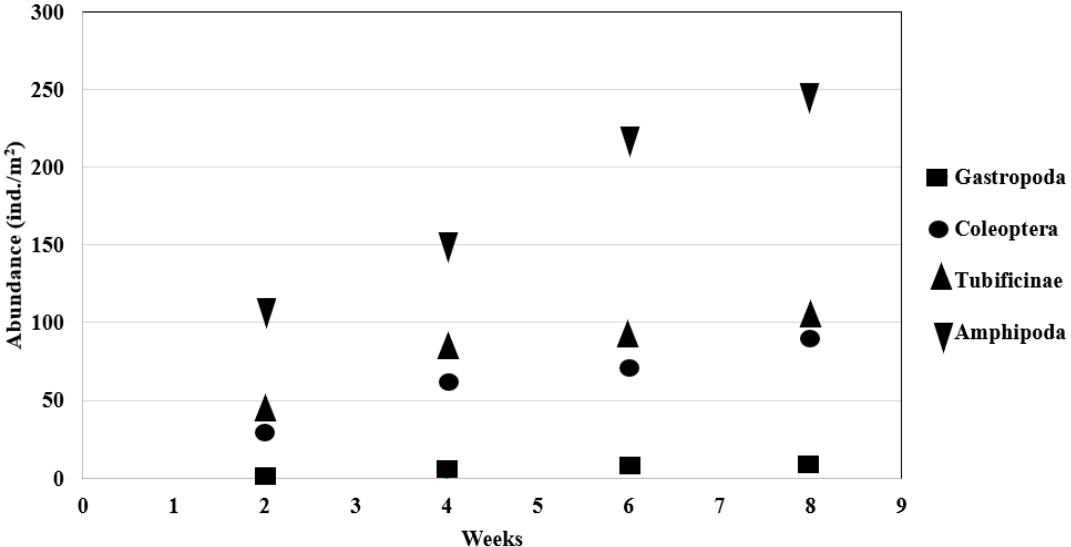
Figure 5. Changes in abundance at successive exposure